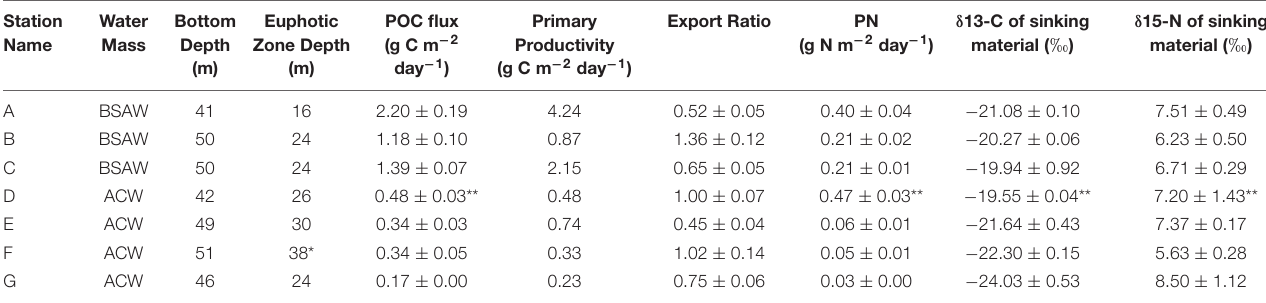
FIGURE 2 | Water mass characteristics from each station where drifting sediment traps were deployed. The size of the circle is indicative of the amount of particulate organic carbon (POC) flux, labeled with station name. Warmer, fresher water characteristic of Alaska Coastal Water (ACW) has lower flux values compared with cooler, more saline water characteristic of Bering Shelf/Anadyr Water (BSAW), which has higher flux values. TABLE 3 | Particulate organic carbon (POC) flux, primary productivity, and export ratios at seven stations in the Bering and Chukchi seas at drifting sediment trap